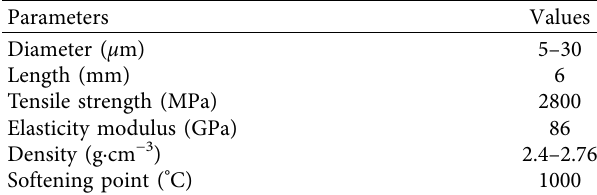
Table 3: Basic properties of the glass fber.